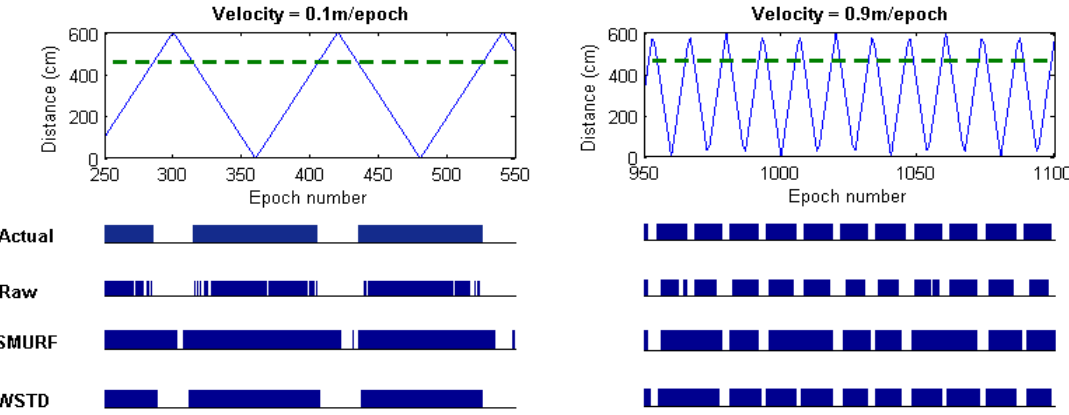
Figure 12. Comparison of WSTD and SMURF schemes’ transition detection mechanisms as a tag moves at constant